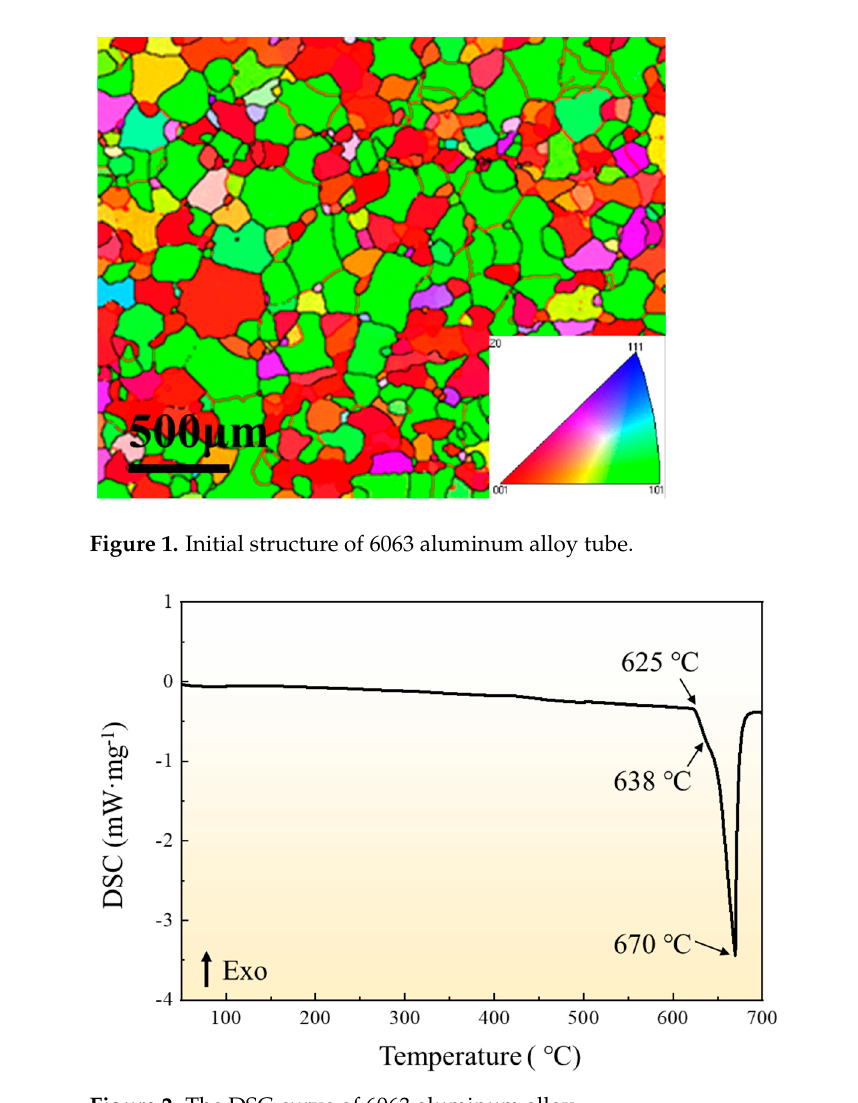
Figure 2. The DSC curve of 6063 aluminum alloy.